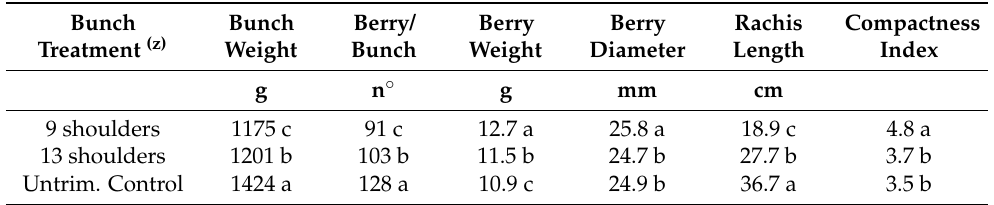
Table 6. Effect of bunch trimming on bunch and berry characteristics of ‘Red Globe’ table-grape vines at a theoretical plant density of 15,600 plants ha − 1 under soil-less cultivation z . Bunch